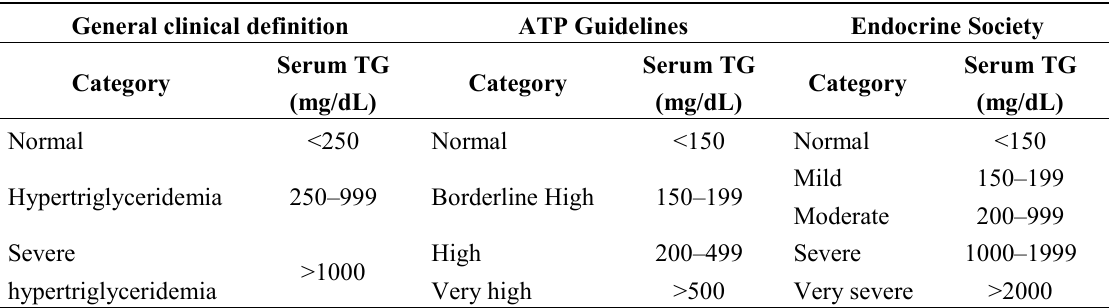
Table 1. Hypertriglyceridemia: some proposed clinical